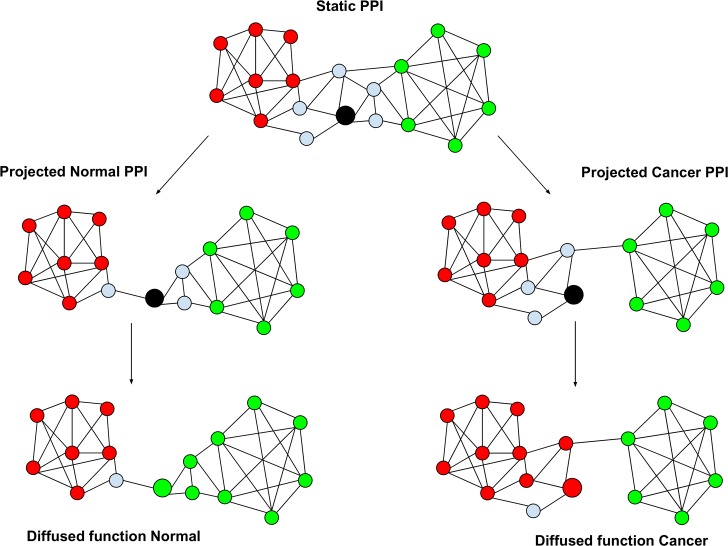
Overall approach.The reference gene is depicted by black circle. The initial static global PIN is projected onto normal and cancer samples based on gene expression, and each function (red and green) are diffused through each PIN. In this case, the reference gene is assigned green function in normal and red function in cancer, i.e., the gene gained red and lost the green function in cancer.